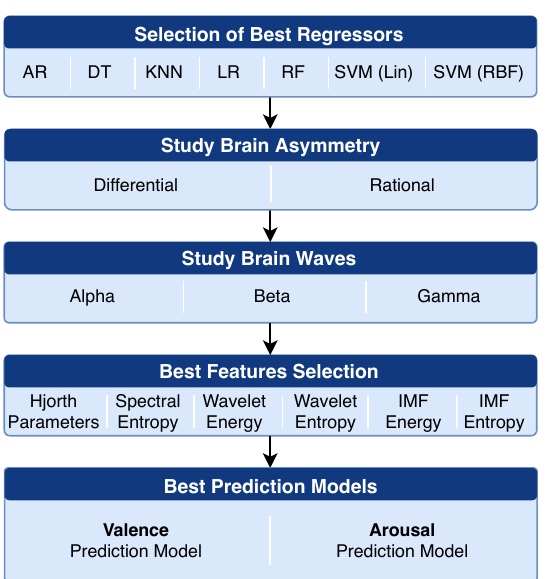
Figure 3. Steps of the analysis to identify the best configuration for our valence and arousal prediction models. (Lin: Linear; RBF: Radial Basis